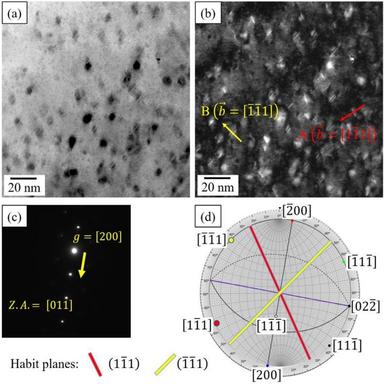
(a) Magnified kinematic bright field and (b) weak beam dark field TEM images of ThO2 after 0.47 dpa proton irradiation at 600oC obtained using zone axis g = conditions, (c) corresponding diffraction pattern showing g vector. (d) stereographic projection at given sample orientation.